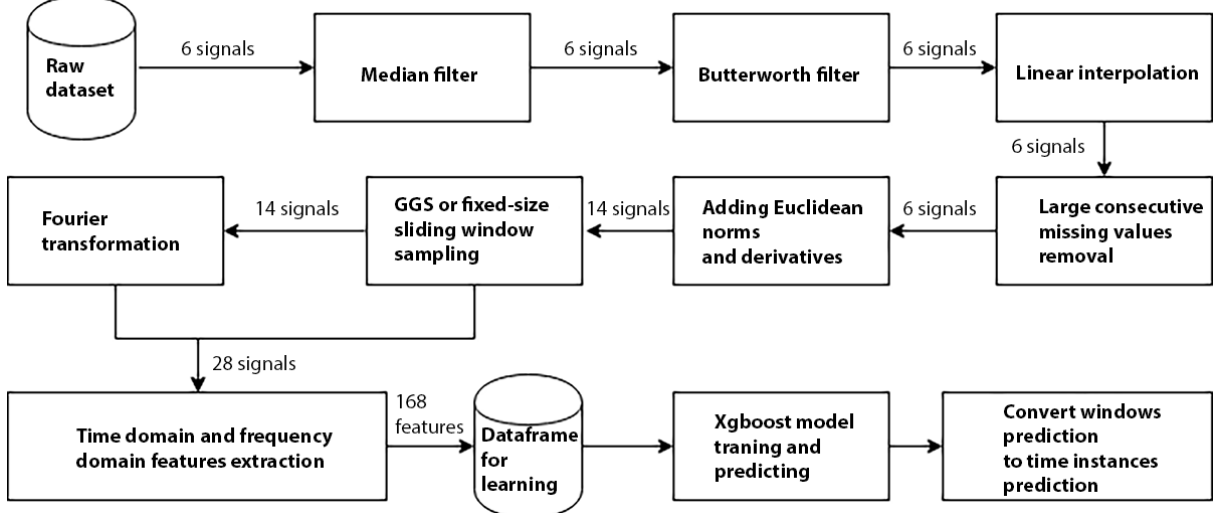
Figure 1. The workflow of the human activity recognition framework. GGS: greedy Gaussian